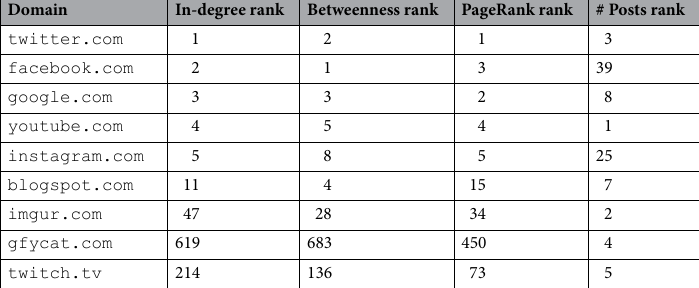
Table 2. The top web domains according to their ranks in multiple centrality measures.